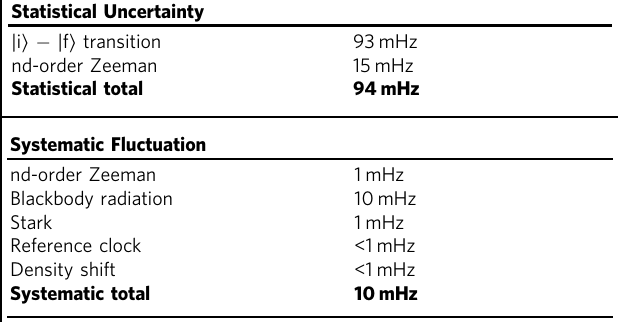
Table 1 Error budget table for the measurement in Fig. 3